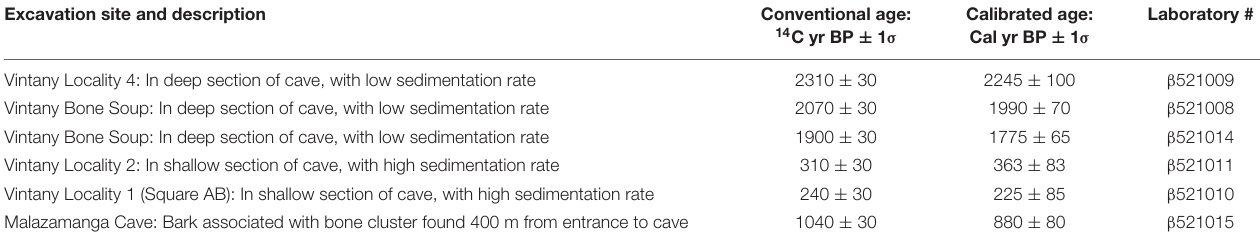
TABLE 5 | Plant material from sediments collected from underwater deposits at Vintany and Malazamanga Caves (Tsimanampesotse National Park), AMS-dated at Beta Analytic Laboratories, FL, United States. Excavation site and